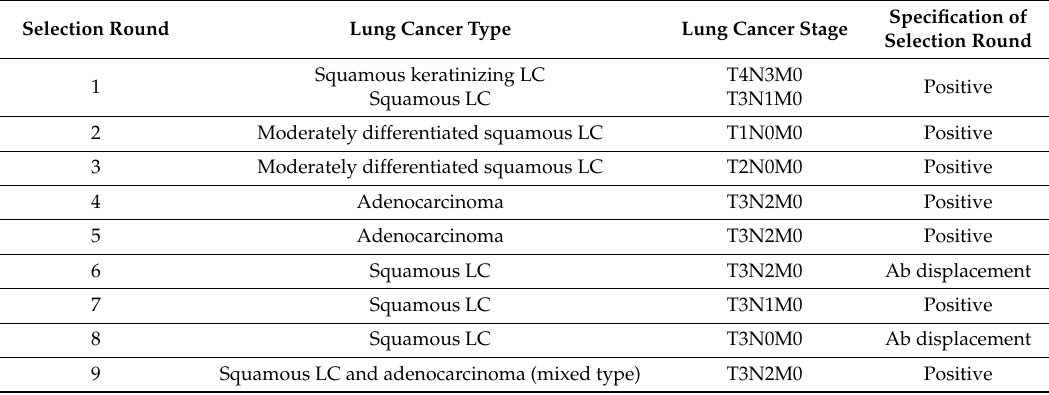
Figure 1. The scheme of DNA aptamer selection using aptamer displacement via antibody. The first several rounds include only positive selection and start with the incubation of the ssDNA library or aptamer pools with receptor positive cells, followed by partitioning unbound DNA, and amplifying bound DNA with symmetric and asymmetric polymerase chain reaction (PCR). In the next rounds, positive rounds alternate with antibody displacement steps and include the incubation of aptamers with the receptor positive cells, washing, the displacement of the bound aptamers by antibodies (Ab), and the following amplification of free aptamers. Table 1. Histological types of lung cancer tissues used in the selection of aptamers against epithelial cell adhesion molecule (EpCAM).